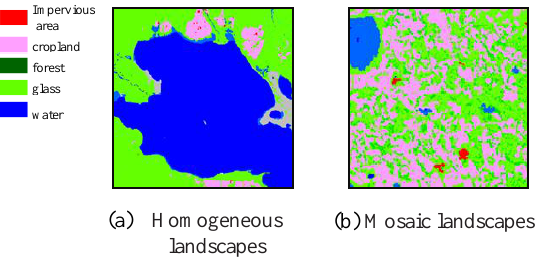
Figure 1. Example of different